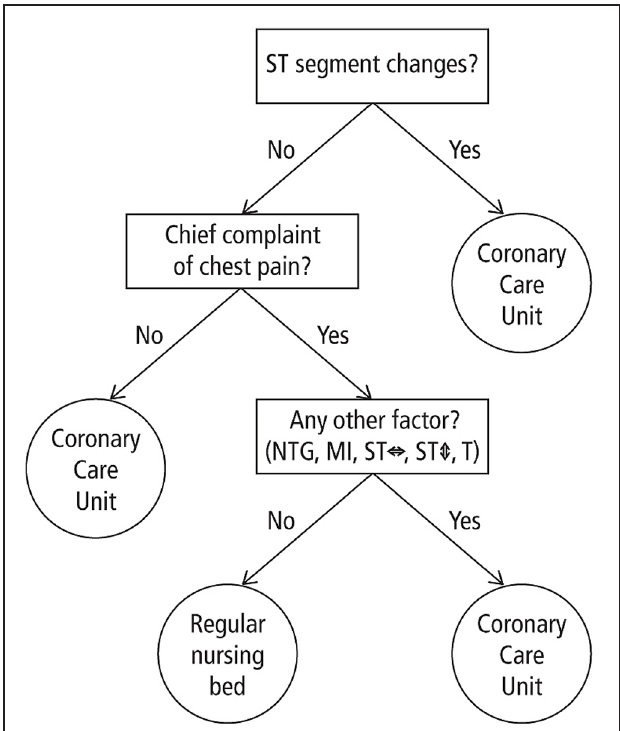
FIGURE 1 | Fast-and-frugal tree for emergency physicians to detect acute ischemic heart disease. It only asks up to three yes/no questions, namely whether the patient’s electrocardiogram shows a certain anomaly (“ST segment changes”), whether chest pain is the patient’s primary complaint, and whether there is any other factor (Based on Green and Mehr,